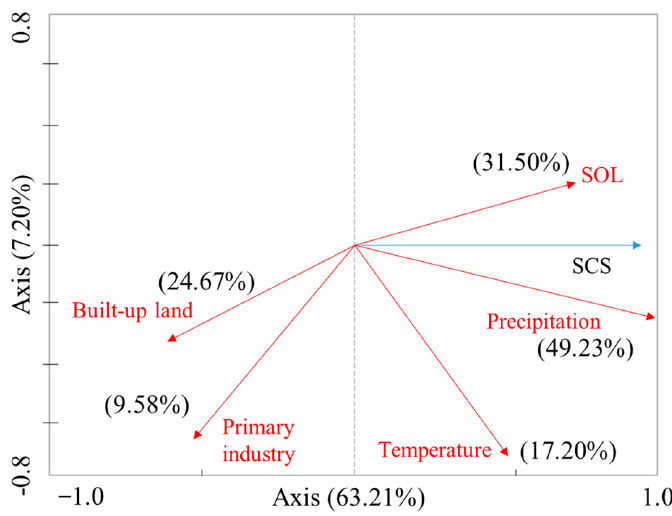
Figure 17. Two-dimensional ranking diagram of redundancy analysis of SCS and five influencing factors.